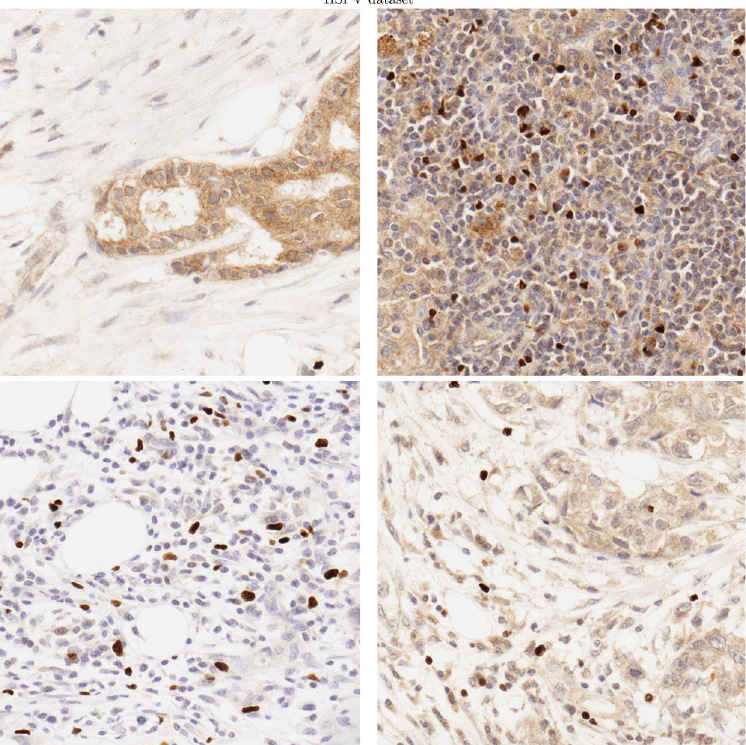
Figure 4. Examples of images from IISPV dataset consisting of DAB&H-stained tissue sections of breast and auxiliary node biopsies, digitized with WSI scanner at ×40